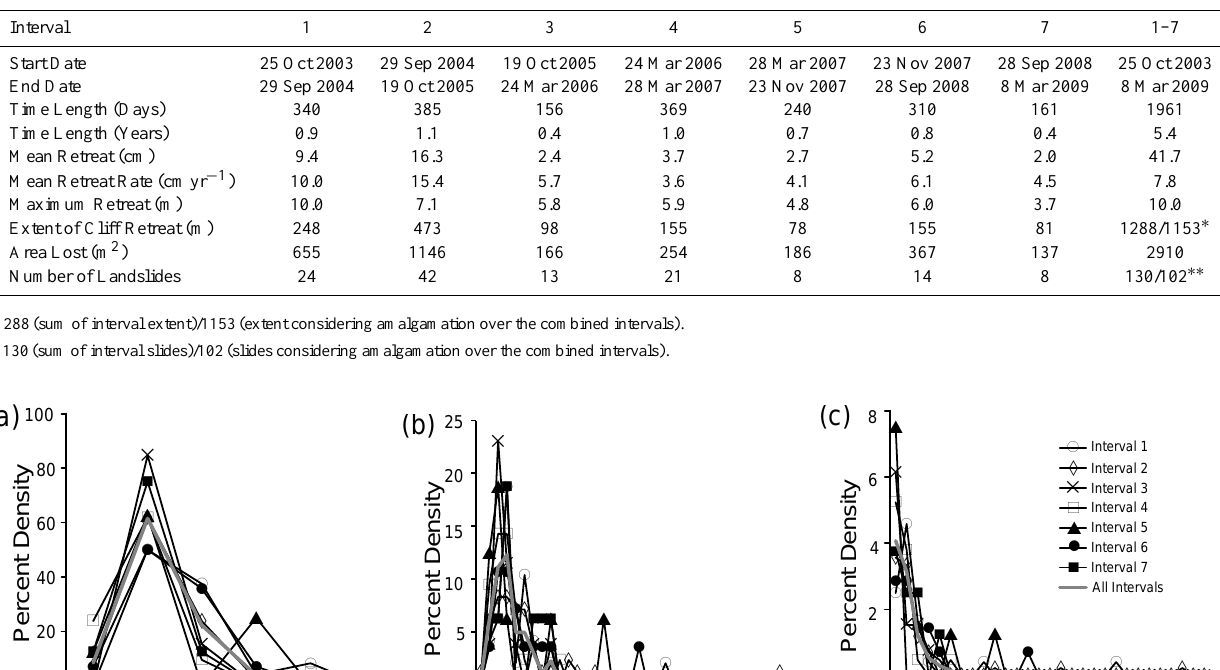
Table 1. Interval information.